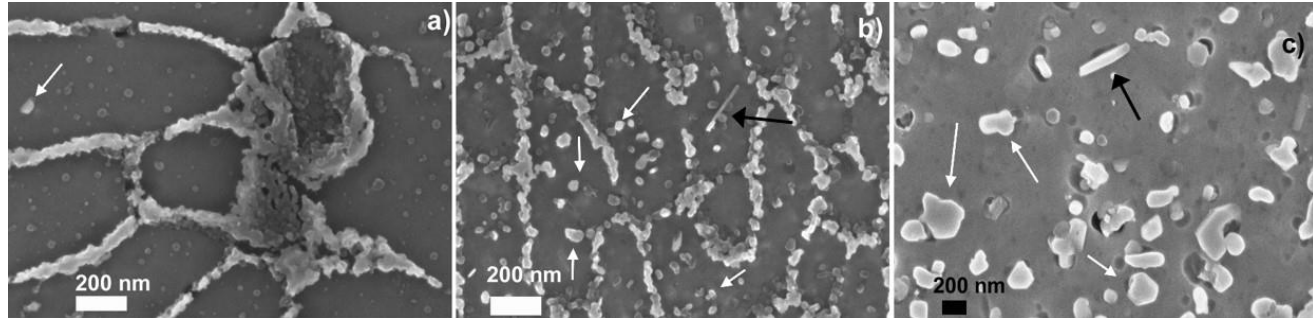
Figure 2. Field-emission scanning electron microscopy (FESEM) images at high magnifications of AlSi10Mg microstructures after etching of ( a ) UT ( b ) 2h-300 and ( c ) 2h-400 specimens. Examples of Si particles are indicated by the white arrows, while the Fe rich needle like particles are indicated by black arrows. (The images are referred to the direction parallel to the building direction — XZ).